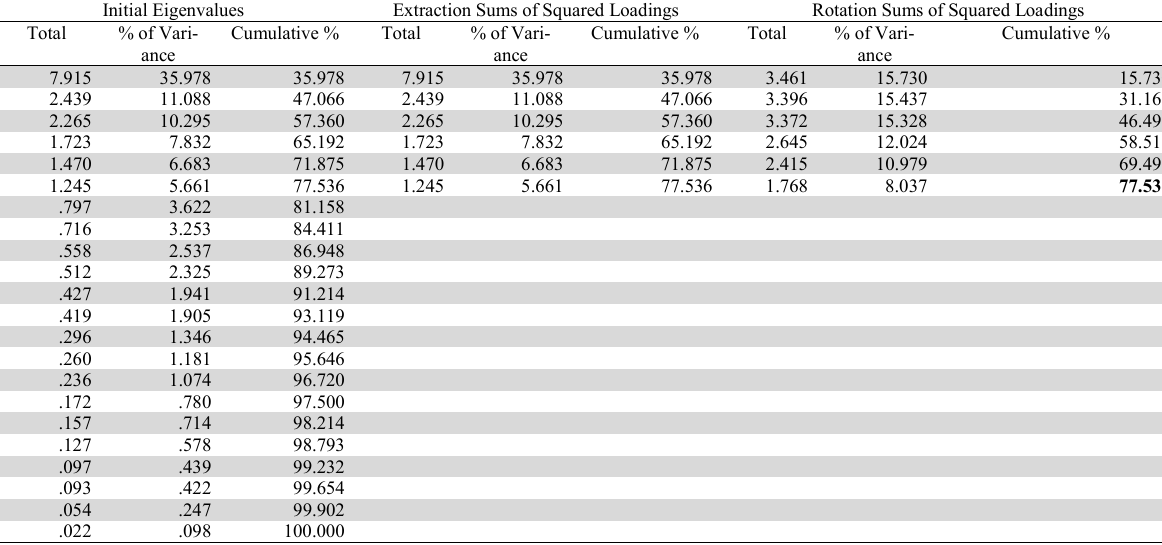
Total Variance Explained Initial Eigenvalues Extraction Sums of Squared Loadings Rotation Sums of Squared Loadings Total % of Vari- ance